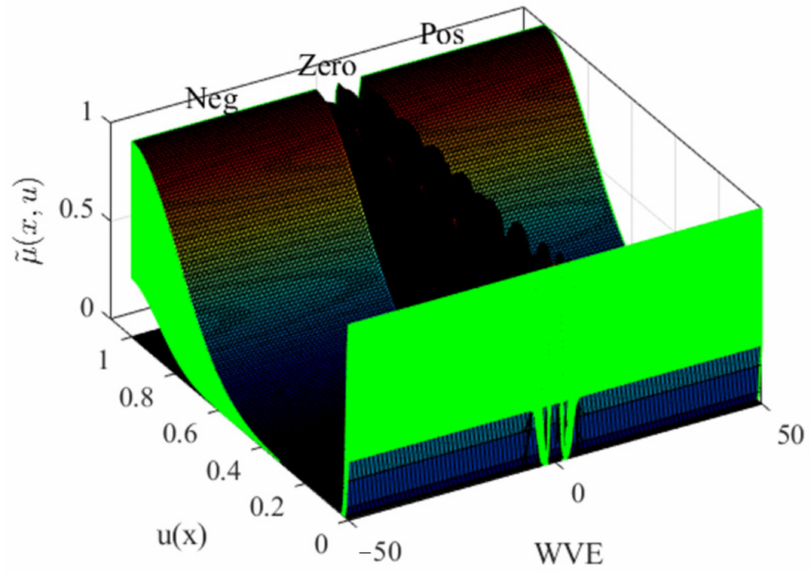
Figure 7. The architecture of the antecedent membership function (WVE). The parameters for the construction of the antecedents are presented in Table